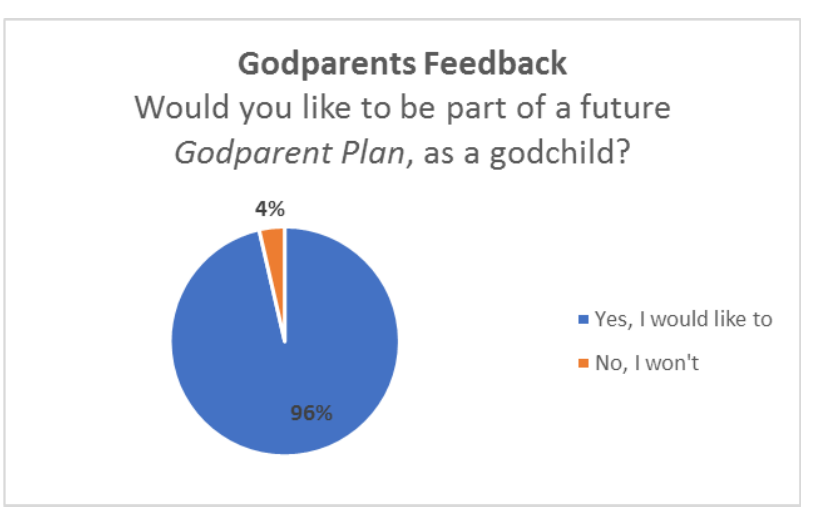
Fig. 5. Godparents’ interest towards being godchildren in a future Godparent